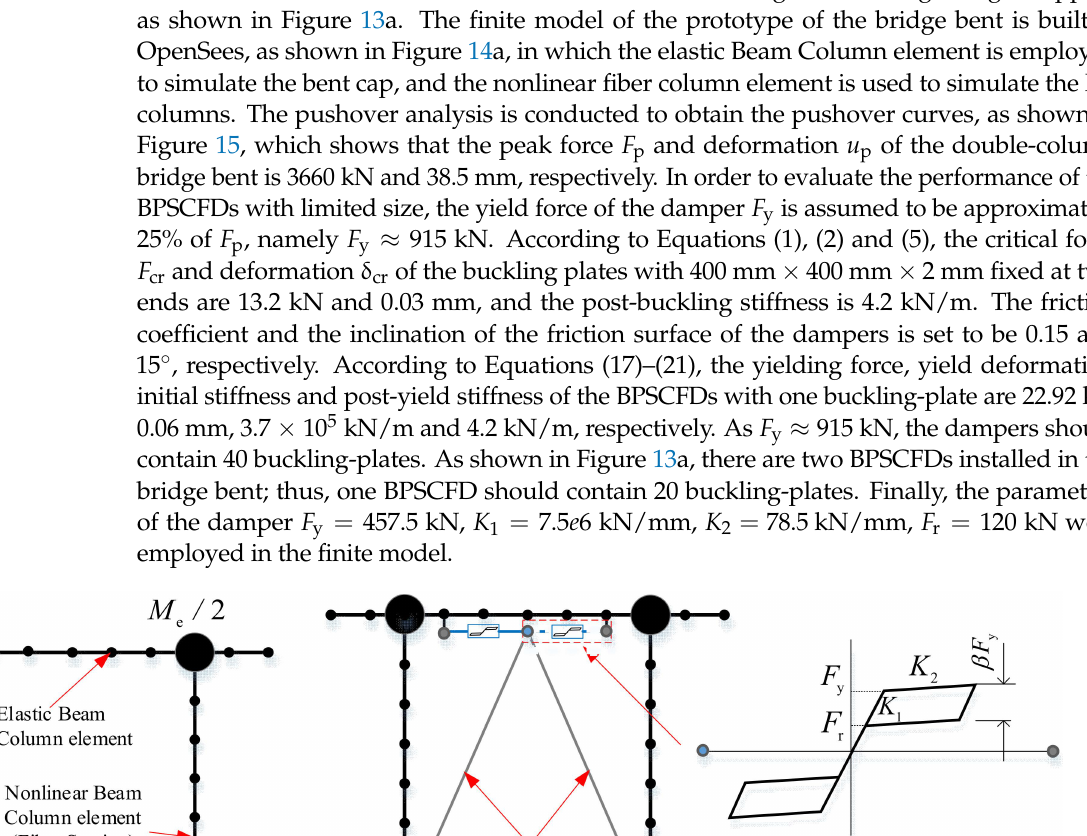
Figure 13. Double-column bridge bent with BPSCFDs: ( a ) schematic diagram of bridge bent; ( b ) Cross-section of columns. Table 3. Information of ground motions.